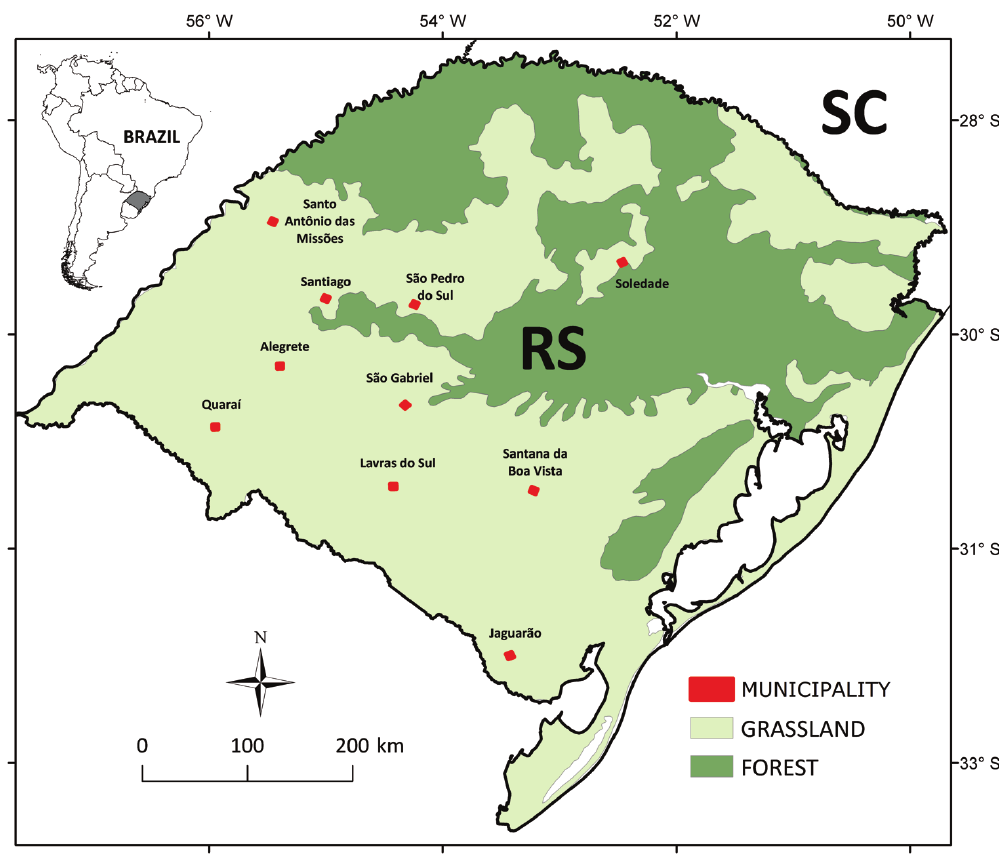
Fig. 1. Location of the ten municipalities in the Rio Grande do Sul State (RS), Brazil, and main land coverage. The landcover map was make with software ArcGIS 10.2 (ESRI, 2013) using the database of Pampa Biome cover of 2009 (UFRGS,